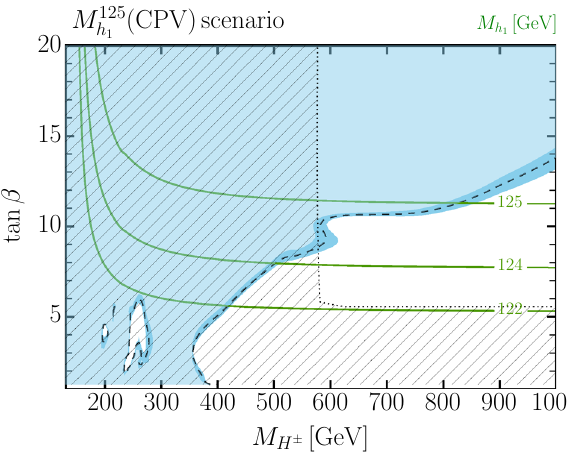
( CPV ) scenario from Higgs searches Fig. 12 Constraints on the M 125 h 1 at the LHC, in the ( M H ± , tan β) plane. The green solid lines are pre- dictions for the mass of the lightest neutral scalar h 1 , the hatched area is excluded by a mismatch between the properties of h 1 and those of the observed Higgs boson, and the blue area is excluded by the searches for additional Higgs bosons (the darker-blue band shows the theoretical uncertainty of the exclusion)